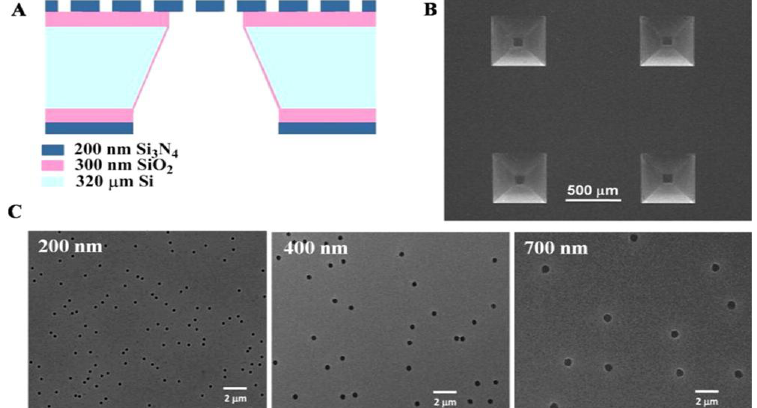
Figure 15. ( A ) Suspended nanoporous Si membrane using SEM; ( C ) Top-view of nanopores of Si diameters using SEM. Reprinted with permission from Langmuir